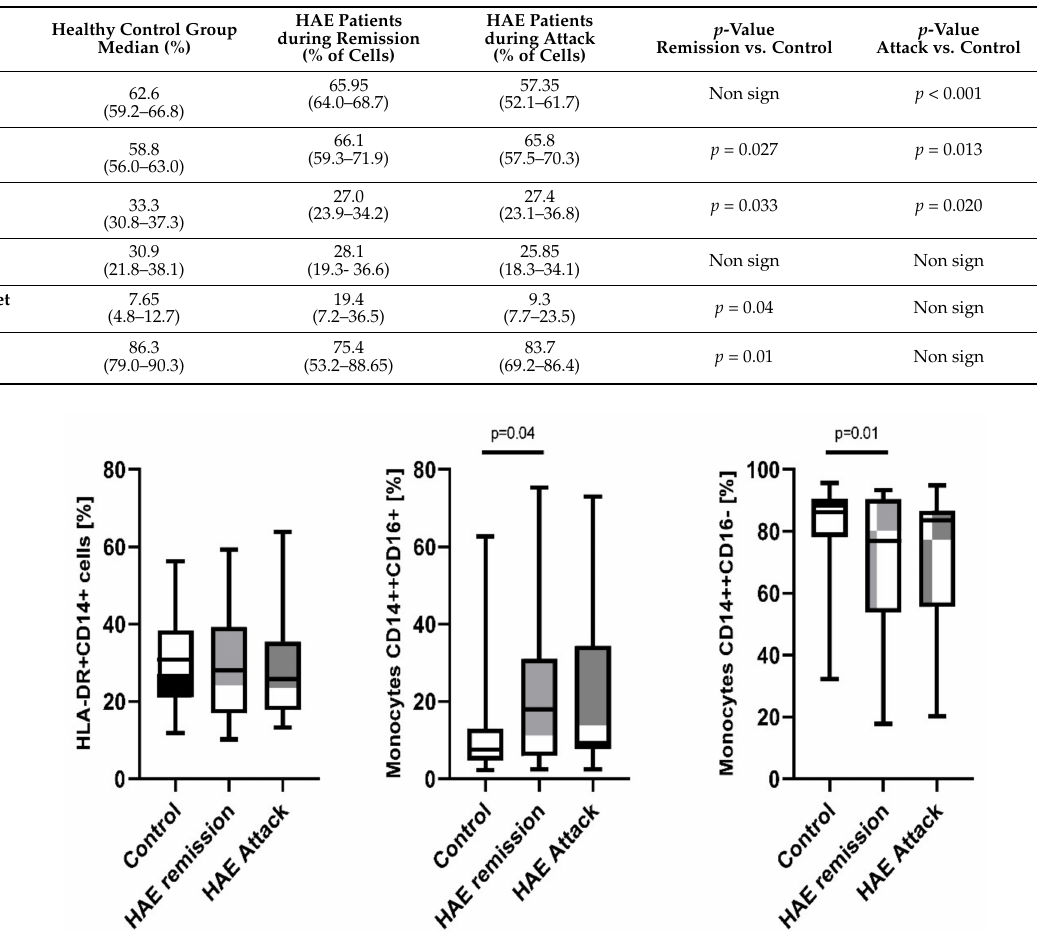
Figure 1. Lymphocytes subpopulations distribution among HAE patients during attack and in remission compared to the healthy control subjects. Table 1. Cells characteristics in the tested cohorts. Data are presented as median and range (Q1; Q3). Statistical significance of the results was analyzed with a Mann–Whitney test.